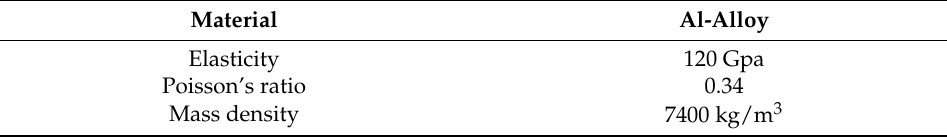
Table 2. Structural specification of the